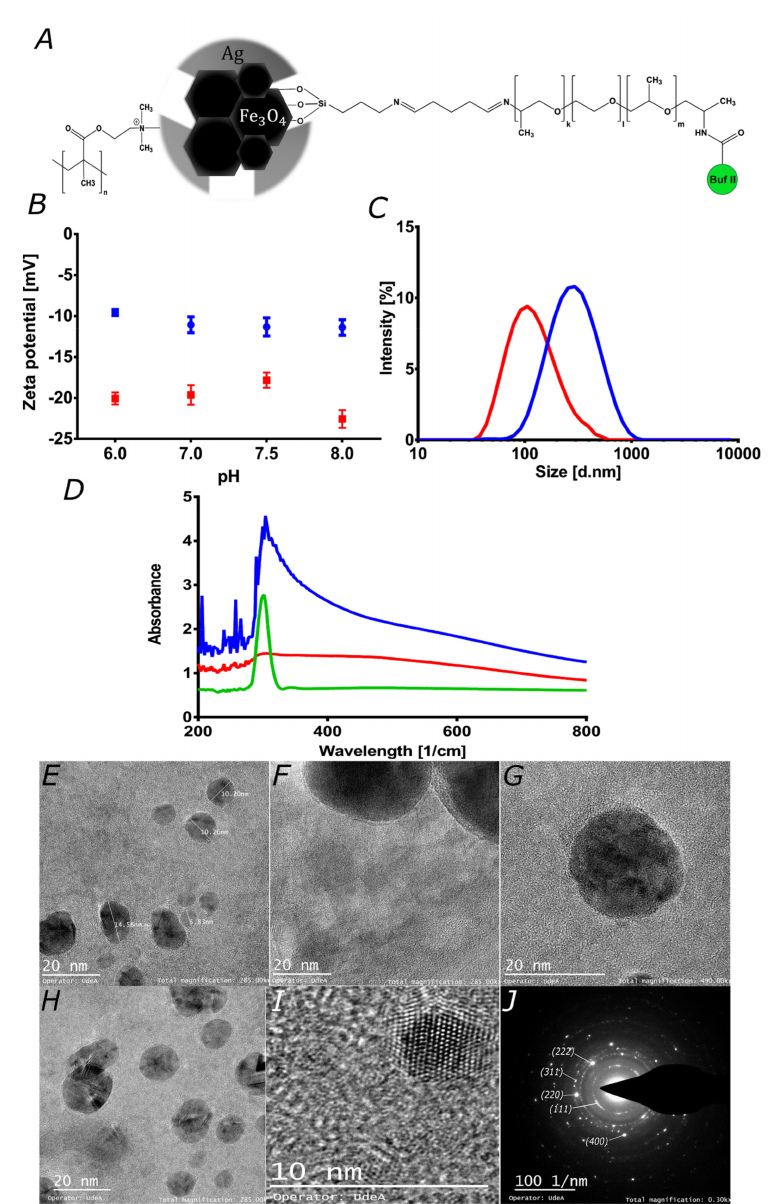
Figure 2. Characterization of magnetite and magnetite / silver. ( A ) Schematic of the chemical structure for the proposed magnetite / silver-pDMAEMA-PEA-BUF-II nanobioconjugate. ( B ) Zeta potential of magnetite (red) and magnetite / silver (blue) nanoparticles. ( C ) Nanoparticles size distribution via Dynamic Light Scattering for magnetite (red) and magnetite / silver (blue). The size of individual particles was visualized in TEM images. ( D ) UV-Visible spectra of magnetite (red), silver NPs (green) and magnetite / silver (blue). These spectra were collected to verify the coverage of silver on magnetite nanoparticles. TEM images of ( E ) magnetite / silver nanoparticles with diameters between 6.8 and 14.5 nm, and ( F ) magnetite clusters covered by a thin layer of silver. ( G ) There seems to be an uneven silver distribution, as evidenced by the coverage surrounding the magnetite clusters shown in the image. ( H ) Clusters of magnetite covered by silver, which is likely to alter the porosity of as-synthesized magnetite, where it was possible to identify di ff erent interplanar distances that correspond to iron oxide and silver crystals. ( I ) Interplanar distance confirms the presence of iron oxide and silver. ( J ) SAED pattern of magnetite / silver nanoconjugates confirms interplanar distances measured in